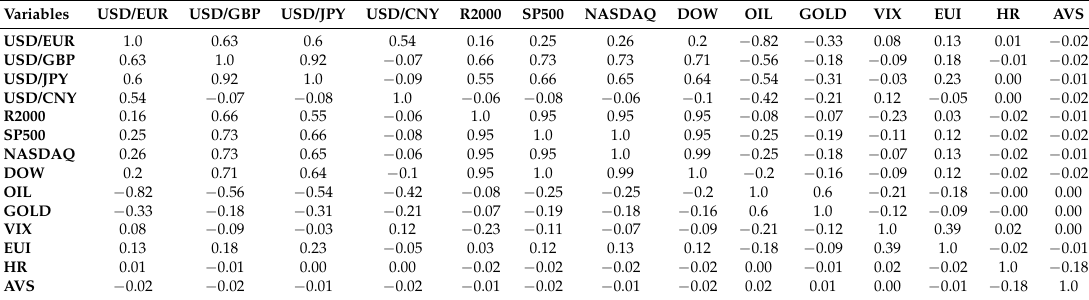
Table 2. Correlation matrix of the explanatory